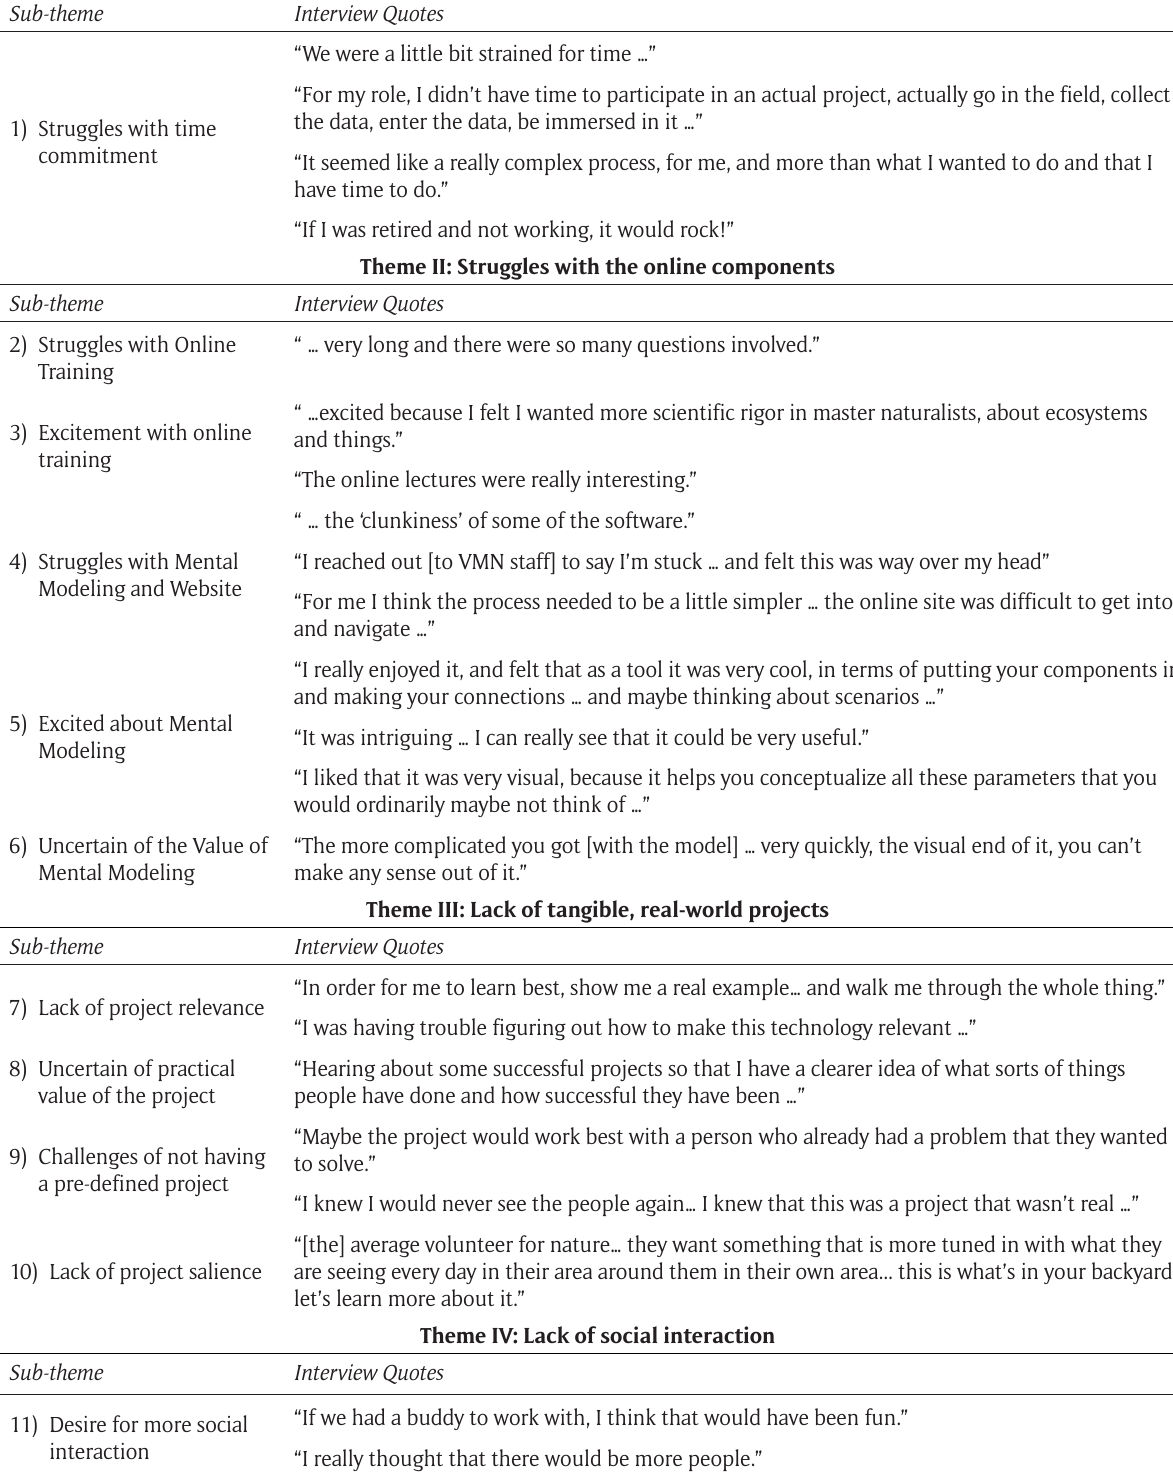
Table 4: Participant interview quotes supporting the four major themes related to volunteer retention in this